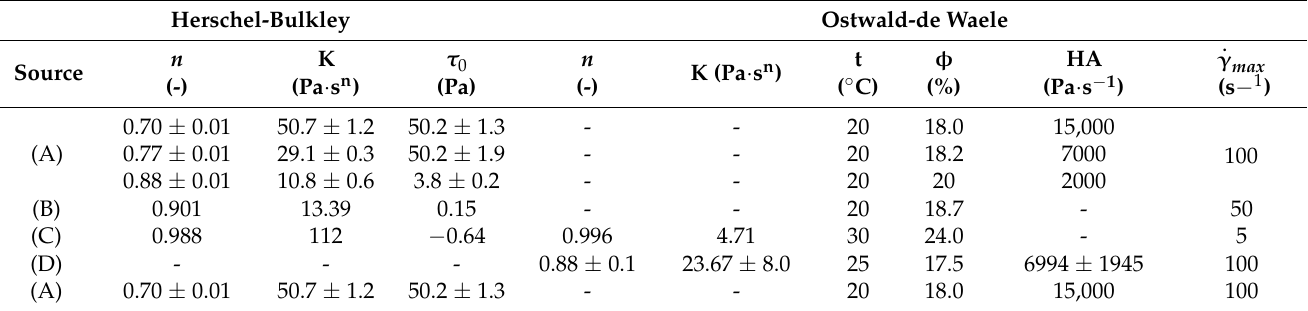
Table 7. Heather honeys’ parameters by various